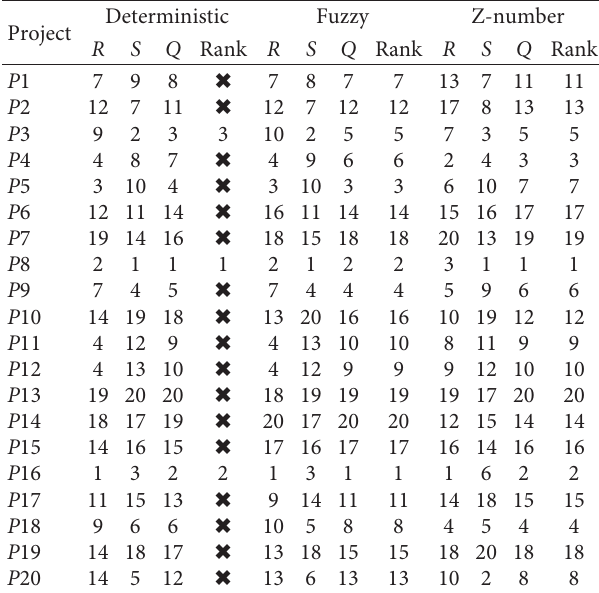
Table 53: Project ranking results using the VIKOR approach under different scenarios (second example: 20